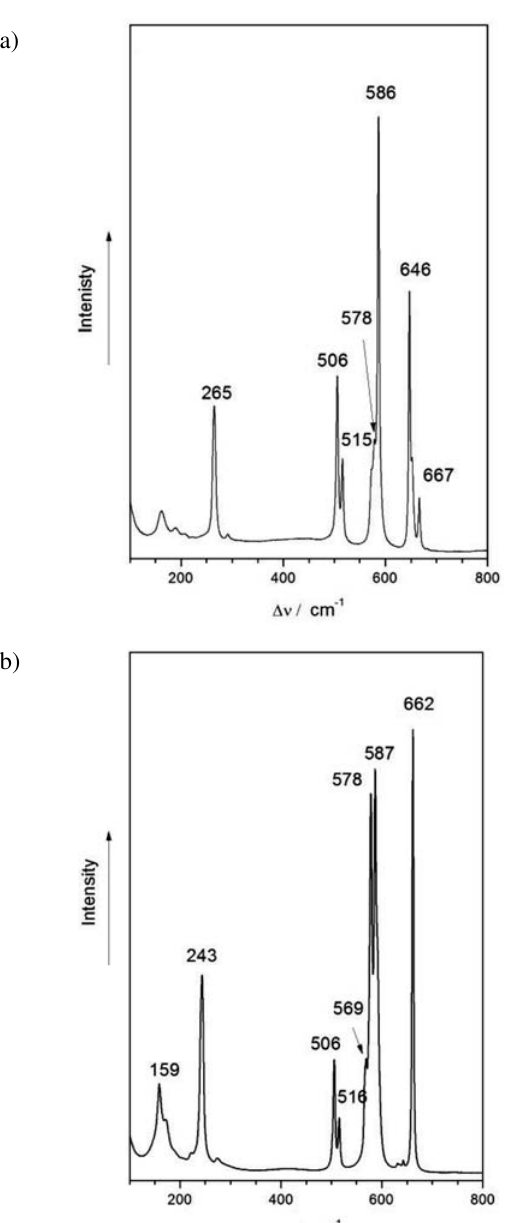
][ RuF ] ·XeF F (a) and 2 3 6 2